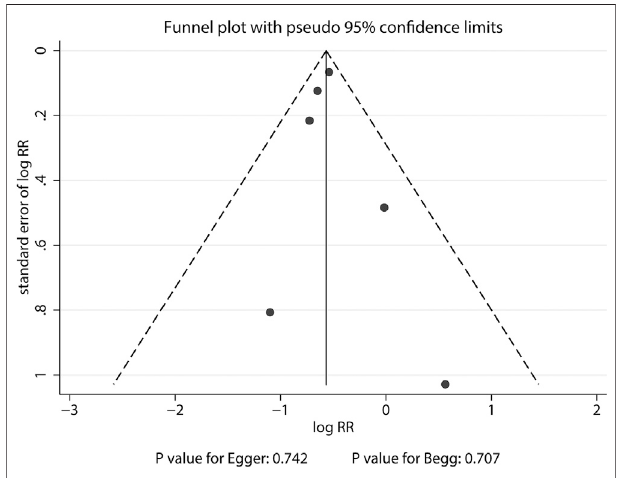
FIGURE5| Funnelplotofclinicalfractures.Apatterndistributionroughly with the shape of a funnel indicates no publication